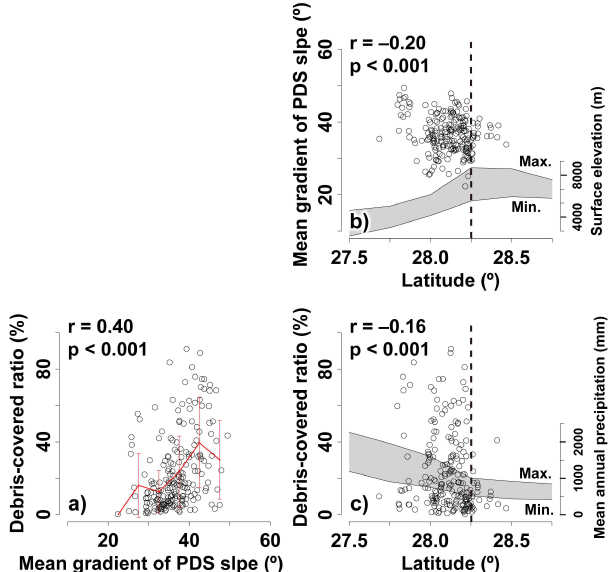
Fig. 9. Relationships between (a) debris-covered ratio and mean gradient of potential debris-supply (PDS) slope, (b) mean gradient of PDS slope and latitude, and (c) debris-covered ratio and latitude in the Bhutan Himalaya. Averages with standard deviation of the debris-covered ratio are calculated for 5 ◦ bins (red lines in (a) ). In (b) , the elevation range derived from ASTER GDEM-2 data shown by grey shading covers the longitudinal area of 88.5–92.5 ◦ E. In (c) , the mean annual precipitation is estimated from the TRMM 3B43 product (1998–2010; 88.5–92.5 ◦ E), shown by grey